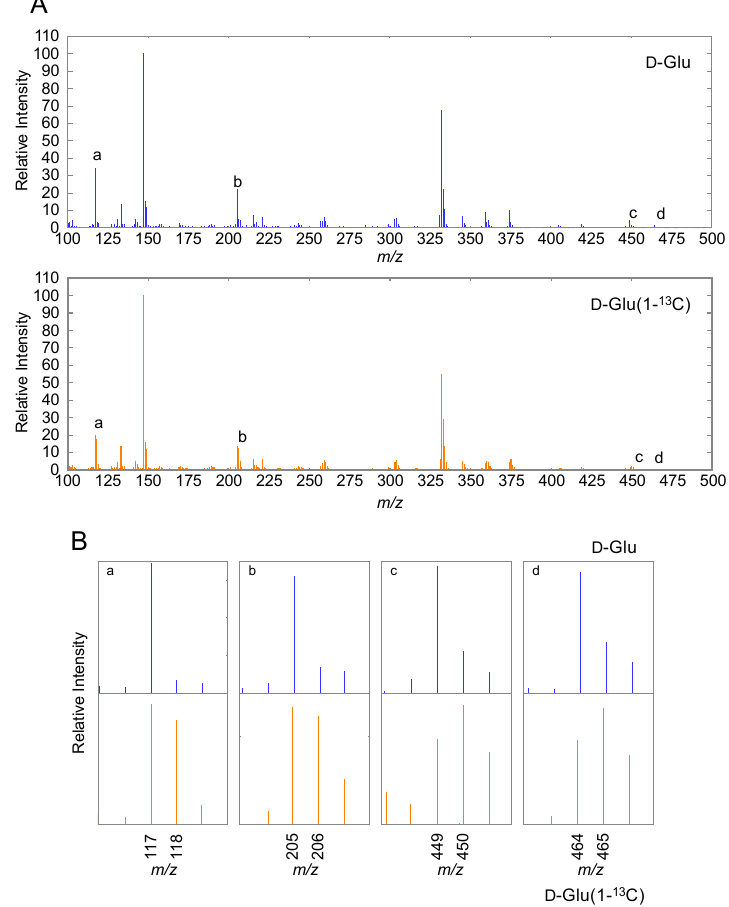
Figure 2. Analysis of AsA in D-Glc or D-Glc (1- 13 C)-labeled Escherichia coli -fed Caenorhabditis elegans by gas chromatography-mass spectrometry (GC-MS). C. elegans preparation and GC-MS analysis were eluted at 8.1 min ( A ). A BSTFA / TMCS-derivatized extract of non-labeled or D-Glc (1- 13 C)-labeled E. coli -fed C. elegans ( B ). An enlarged view of the m / z for the specific fragments labeled a–d is shown in the upper panels. Blue line indicates GC-MS fragment pattern in non-labeled E. coli -fed C. elegans (D-Glc). Orange line indicates D-Glc (1- 13 C)-labeled E. coli -fed C. elegans (D-Glc (1- 13